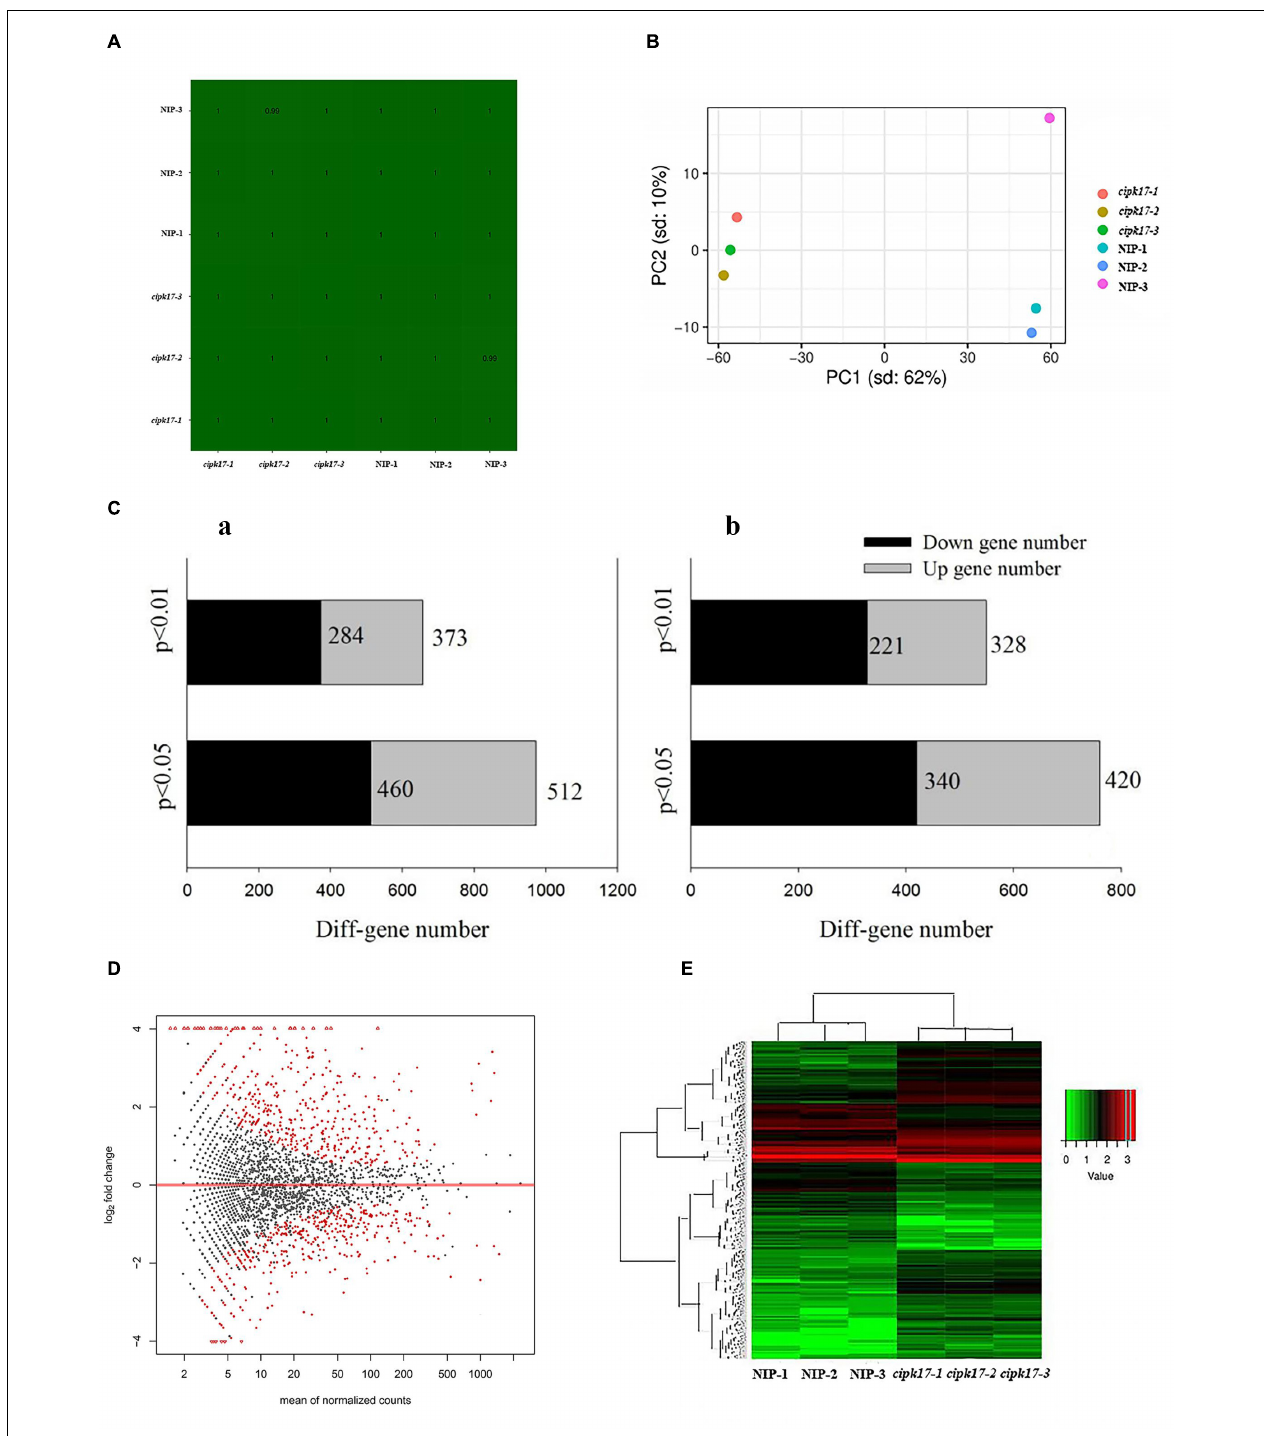
FIGURE 4 | Quality control of transcriptome data and expression analysis of differential genes. (A) Correlation cluster analysis of samples. (B) Principal component cluster analysis of sequencing samples. (C) Quantitative analysis of differential genes screened by transcriptome sequencing; a of panel (C): differential genes screened by p -value; b of panel (C): differential genes screened by fold change threshold. (D) Volcano map of differentially expressed genes. The X -axis is the average expression value of all samples used for comparison after standardization, and the Y -axis is log 2 foldchange. The difference genes are marked in red with p -value < 0.05. (E) Cluster heat map of differentially expressed genes. Red indicates high expression genes and green indicates low expression genes.